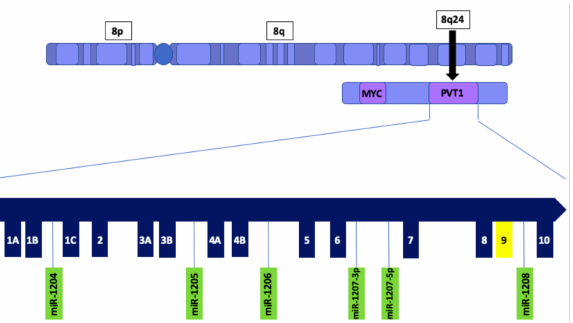
Figure 1. Schematic illustration of PVT1 showing exons and microRNAs. PVT1 is located down- stream of the MYC gene on chromosome 8q24. PVT1 exon 9 is highlighted in